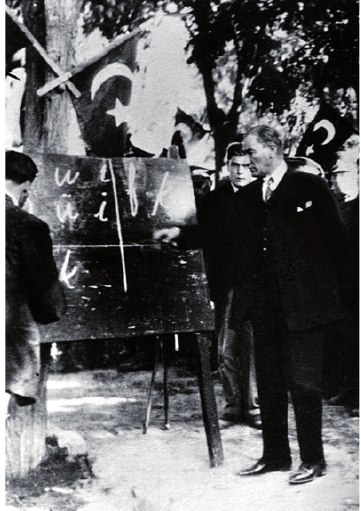
Fig. 5. Atatürk in Kayseri (Sep.